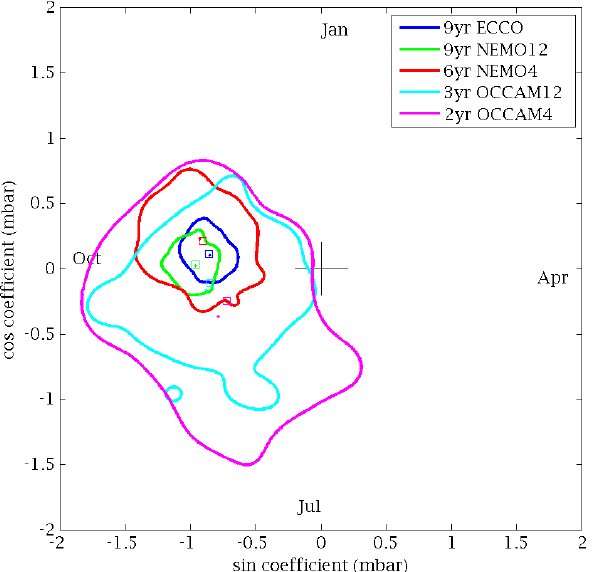
Figure 12. 95% noise contours for annual amplitude and phase fitted to each site simultaneously with noise, using ECCO (blue), NEMO12 (green), NEMO4 (red), OCCAM12 (cyan) or OCCAM4 (magenta). Note that the latter models have only a short overlap in time with the bottom-pressure data.